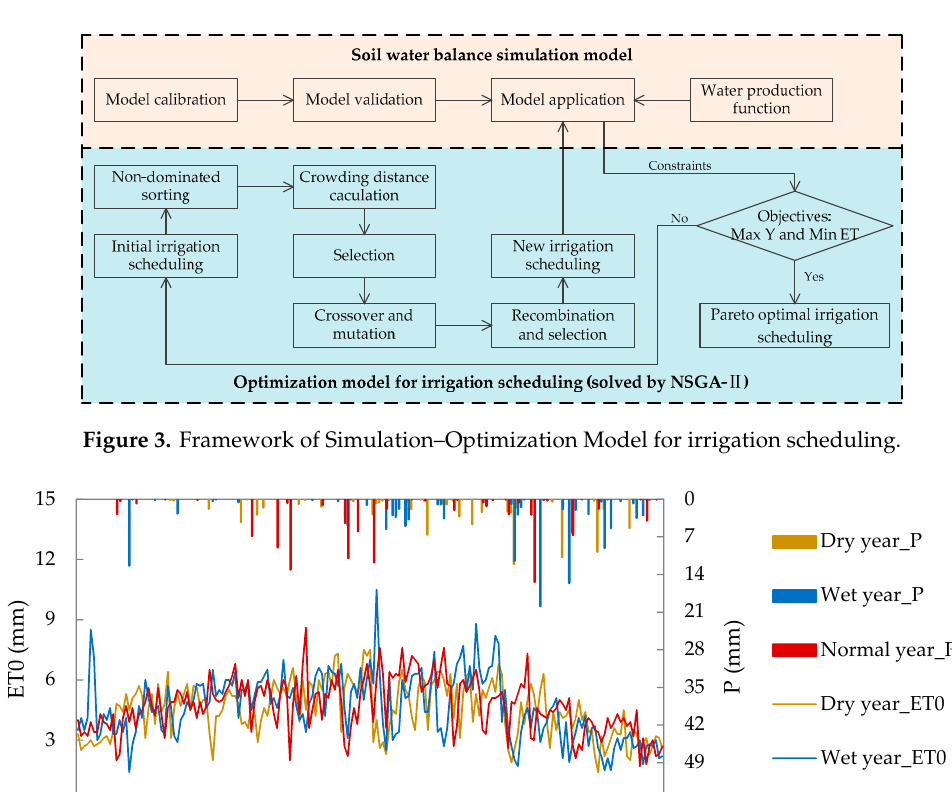
Table 2. Calculated parameters of soil water balance simulation